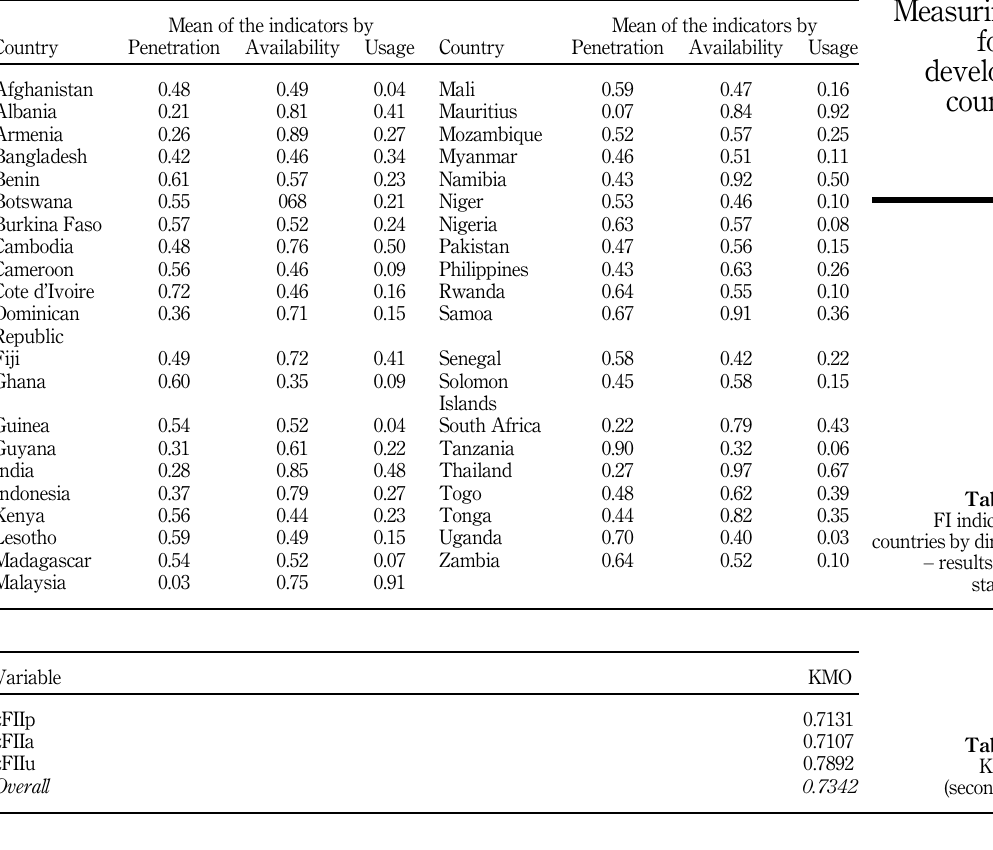
Table A5. KMO test